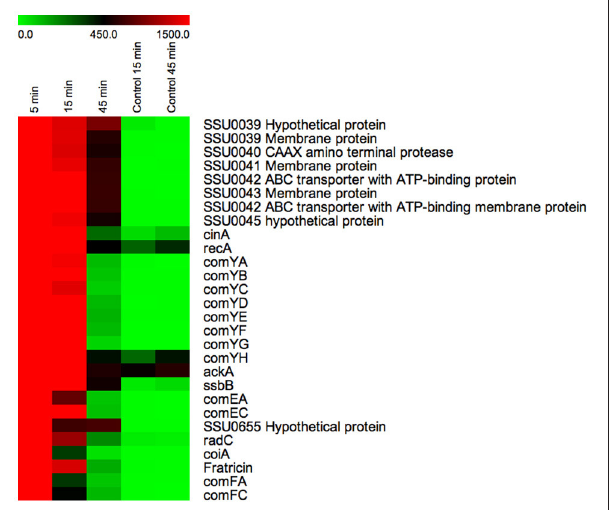
FIGURE 4 | Temporal expression of the genes under direct regulation of ComX. Heatmap displaying the temporal expression of predicted ComX-regulated genes during competence development. The color scale at the top depicts the normalized, unlogged expression values of the genes indicated on the right. The heatmap colors represent gene expression levels from the lowest value (zero, light green) to the highest level ( ∼ 3000, bright red). To not lose resolution of intermediary expression levels, a highest cut-off value of 1500 was applied to the heatmap display. The time at which bacterial samples were rapidly centrifuged and suspended in RNAprotect buffer is indicated above each column. “Control” indicates bacterial cultures to which no inducing peptide was